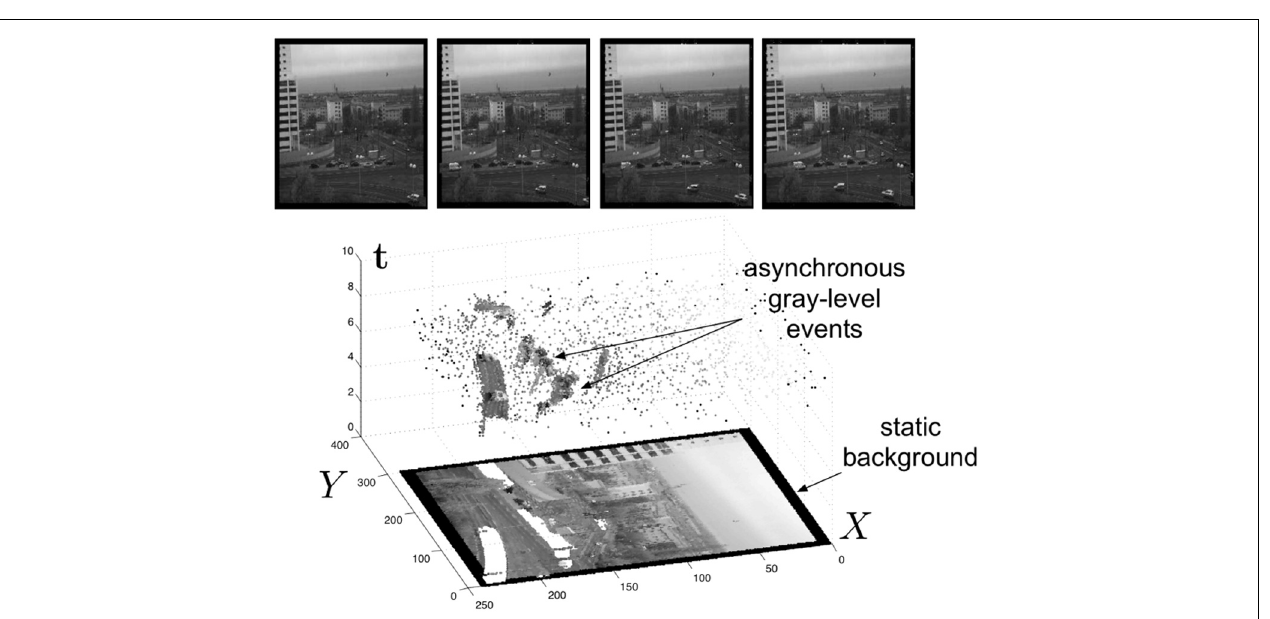
FIGURE 2 | Lower part The spatio-temporal space of imaging events: static objects and scene background are acquired first. Then, dynamic objects trigger pixel-individual, asynchronous gray-level events after each